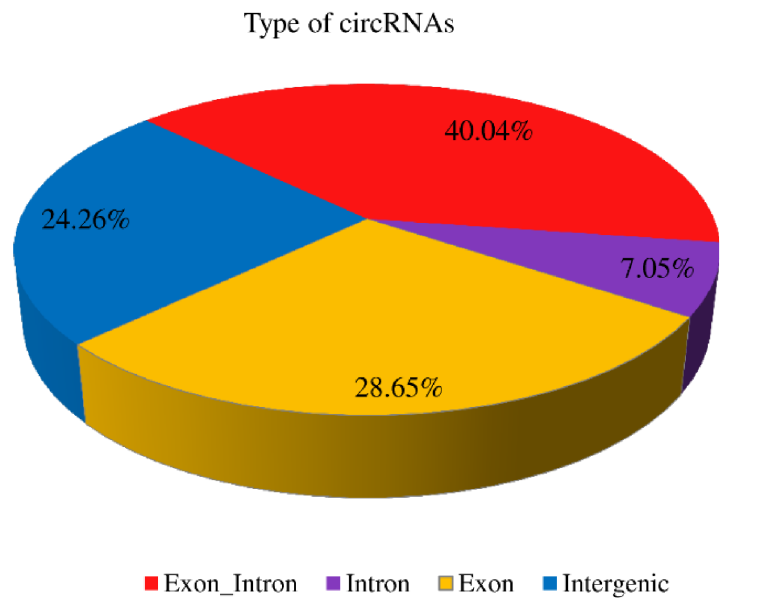
Fig 2. Percentages of the four types